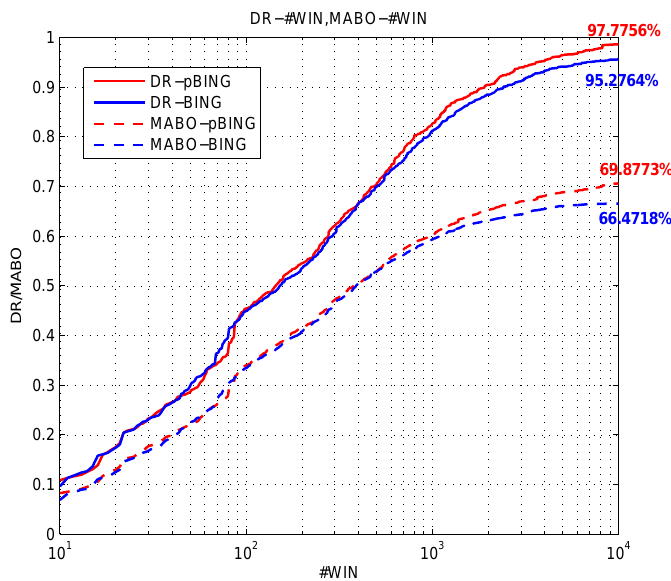
Figure 6. Tradeoff between #WIN and the detection rate (DR)/mean average best overlap (MABO) on the dataset LARGE-FIELD-RSIs.